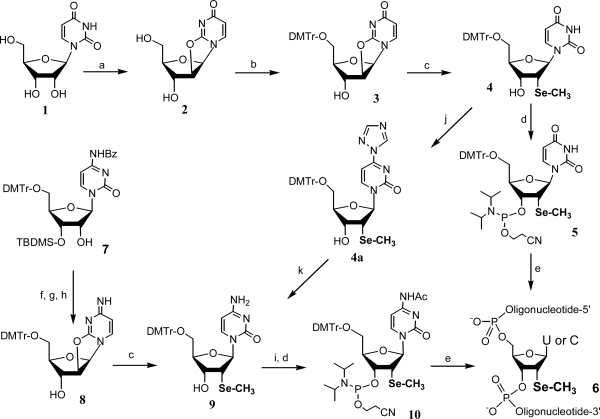
Improved synthesis of 2’-methylseleno contained uridine and cytidine phosphoramidite and their incorporation into oligonucleotides. (a) (Ph)2CO3, Na2CO3, DMF; (b) DMTr-Cl, Py; (c) NaSeCH3, EtOH-THF; (d) 2-cyanoethyl N,N-diisopropyl-chlorophosphoramidite and N,N-diisopropylethylamine in CH2Cl2; (e) synthesis of oligonucleotides on solid phase; (f) Ms-Cl, TEA, THF; (g) toluene/tetrahexylammonium hydrogen sulfate, Na2CO3 (satd); (h) (Bu)4N+ F−, THF; (i) TMS-Im, then Ac2O, TEA and DMAP in THF; (j) TMS-Im, then POCl3-triazole-TEA in CH3CN; (k) NH4OH.